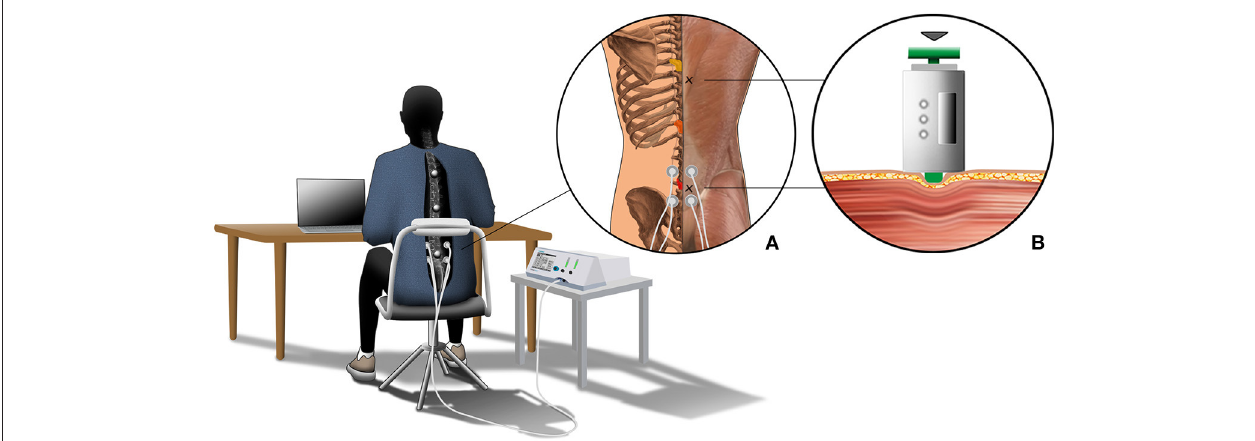
FIGURE 1 | The graphical depiction illustrates the experimental setup. All participants sat for 4.5h at a desk on a height-adjustable chair to complete their regular office activities. The chair’s back cushion was removed, leaving only the metal frame cushioned with foam to guarantee marker visibility. Further, all participants had to wear a long-sleeve T-shirt with a cut-out at the back exposing the spinal area. Motion data of the back were captured using three retro-reflective skin markers, which were placed on the spinous processes of vertebrae T5, T10, and L2. The three vertebrae are colored in yellow (T5), orange (T10), and red (L2) in close-up (A) . Further, close-up (A) shows the locations of the stiffness measurement (marked with an x) and details about the NMES condition. Here, two electrodes were placed on the left and right sides of the lumbar spine. Close-up (B) shows details about the passive muscle stiffness measurement. Muscle stiffness was defined by the slope of the relationship between indentation depth and resistance